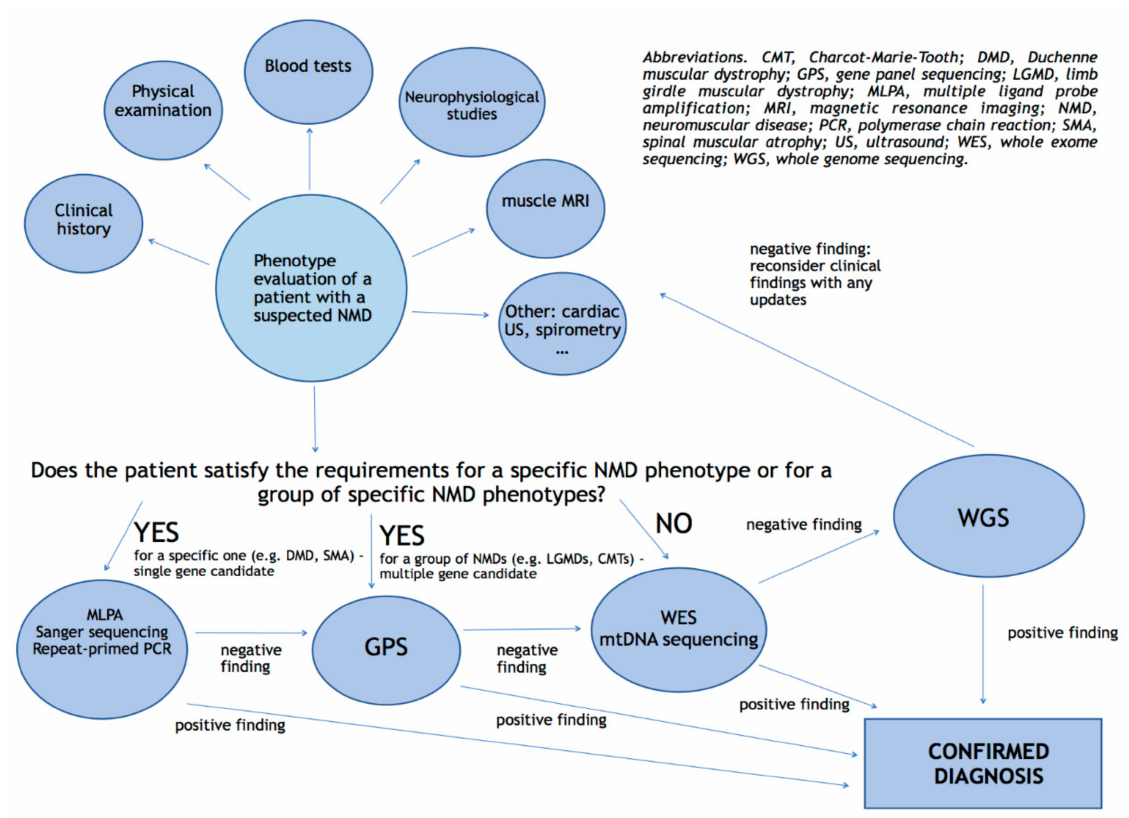
Figure 2. Proposal for a diagnostic algorithm of genetic testing in